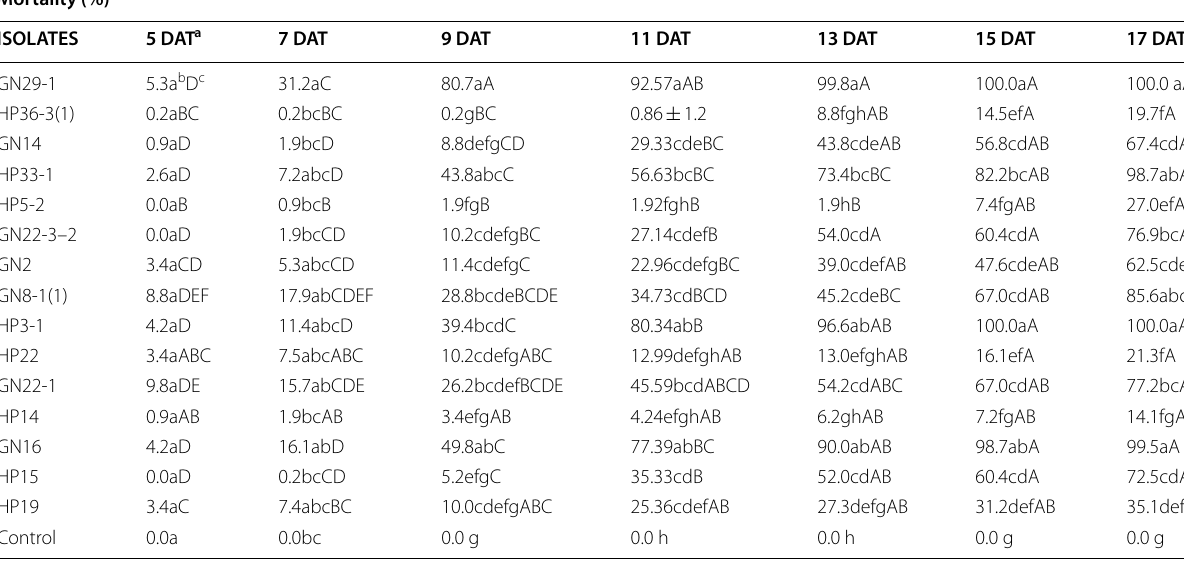
a DAT: Days after treatment b Means in a column followed by the same lowercase letter are not statistical significantly different (ANOVA P < 0.05, Tukey’s test) c